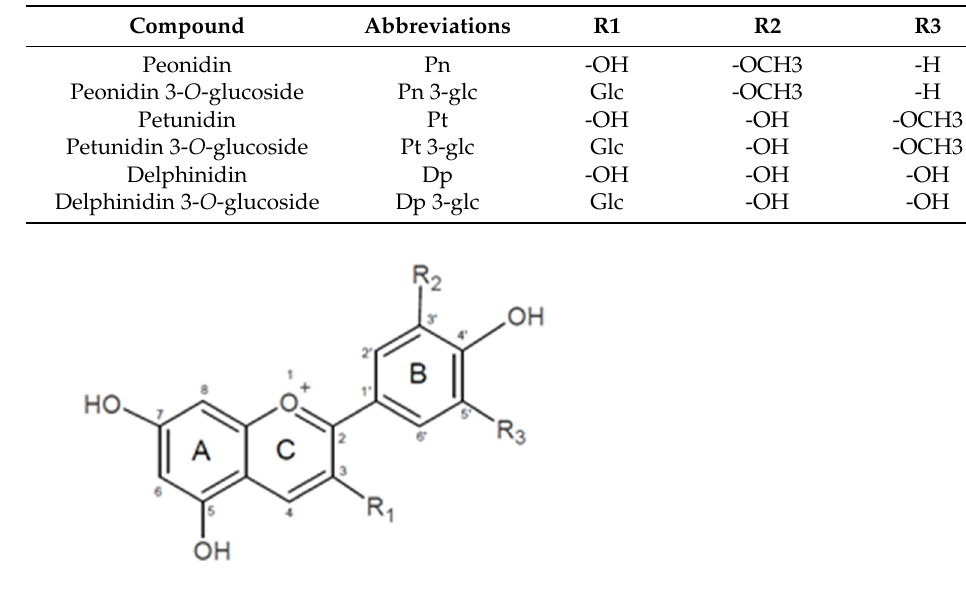
Table 1. The chemical structure of the compounds